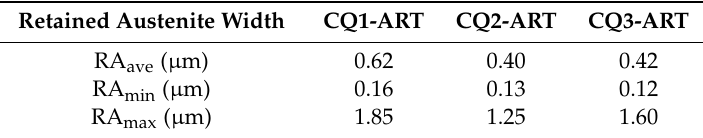
Figure 3. SEM and TEM micrographs of ( a )–( c ) and ( d )–( f ) for cycle quenching and austenite reverse transformation (CQ-ART) samples, respectively, ( a , d ) CQ1-ART sample, ( b , e ) CQ2-ART sample and ( c , f ) CQ3-ART sample. Table 2. Statistical data of austenite width by Digital-Micrograph.